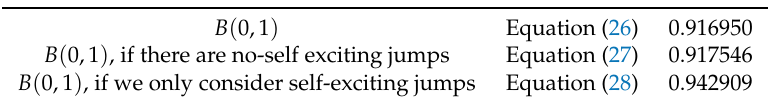
Table 9. Bond price B ( 0,1 )